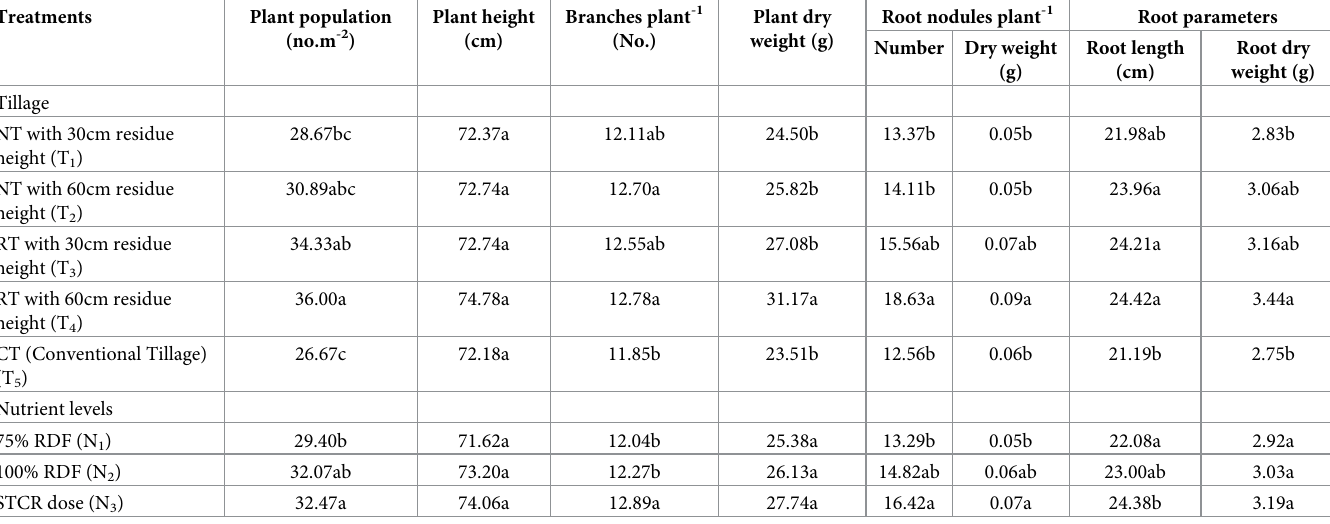
Table 2. Effect of tillage practices, crop residue management and nutrient levels on plant growth attributes of chickpea.